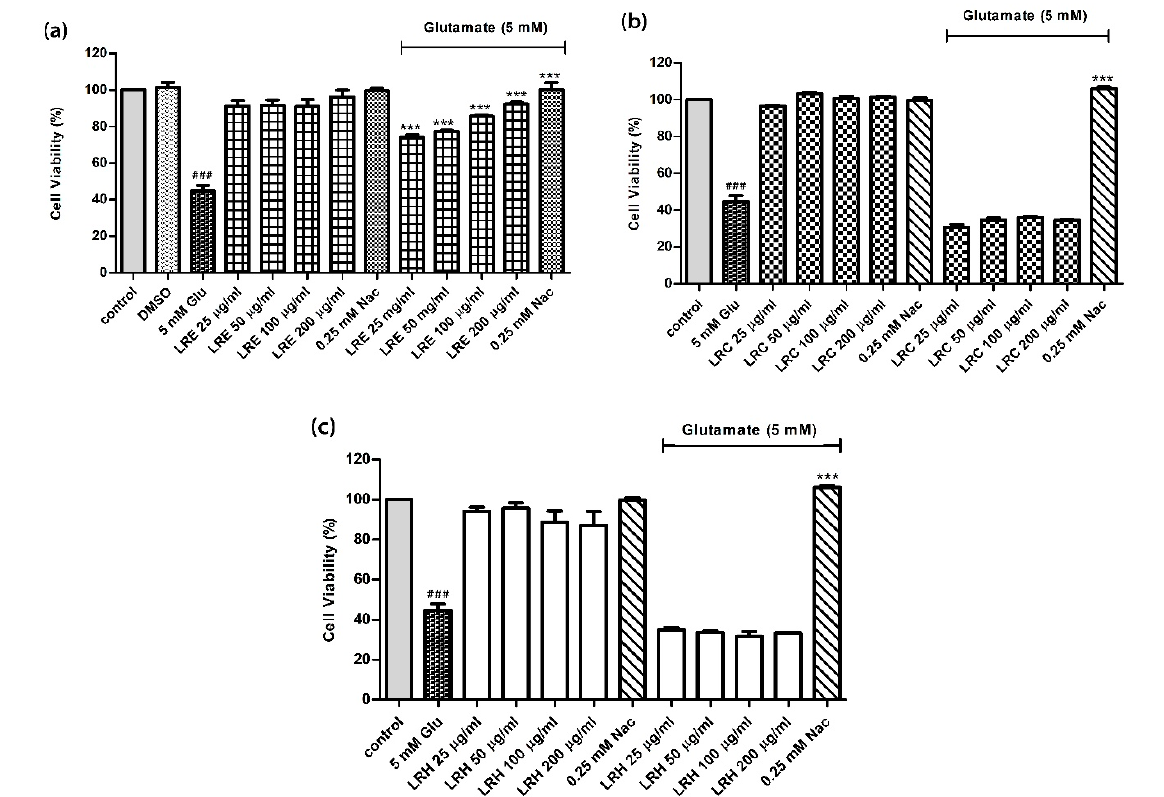
Figure 1. The protective effect of different concentrations of Lignosus rhinocerus (LR) extracts against glutamate-induced toxicity in HT22 cells. Viability of untreated control cells was set at 100%. ( a ) Treatment of cells with an LR ethanol extract (LRE) and LRE plus glutamate; ( b ) Treatment of cells with LRC and LRC plus glutamate; ( c ) Treatment of cells with LRH and LRH plus glutamate. Values are mean ± SEM of at least three independent runs. Significant differences: ### p < 0.001 vs. control; *** p < 0.001 vs. glutamate alone.